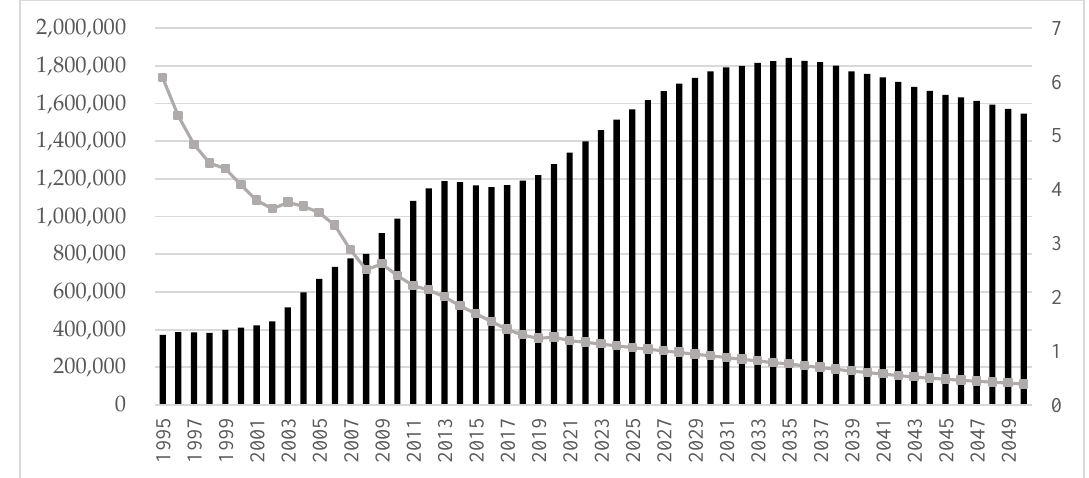
Figure 3 . Simulation of China’s carbon emissions from 2020 to 2050. Figure 3. Simulation of China’s carbon emissions from 2020 to 2050. Table 2. Calculation results of China’s carbon emission factor analysis from 1995 to 2019.